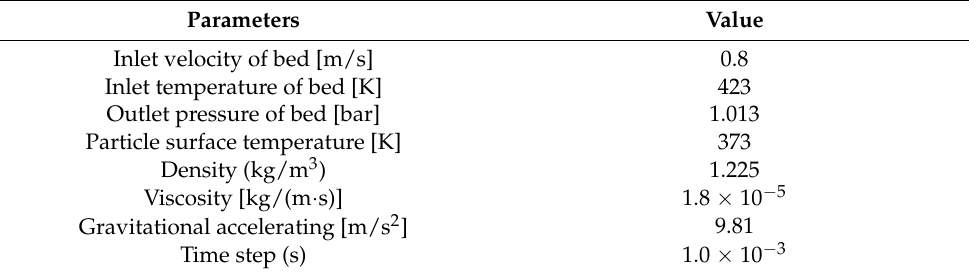
Figure 1. Simulation steps for the construction of the randomly packed bed using the DEM method.